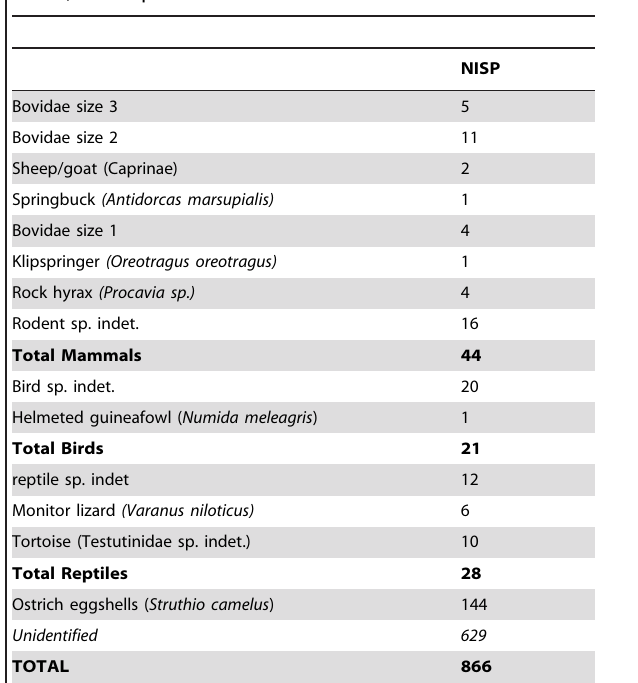
Table 2. Faunal list of the squares N7, M7 and O7 (layers 5 and 6) of Leopard Cave.